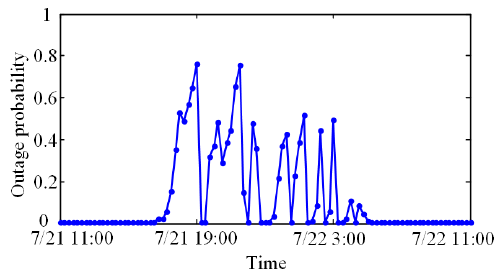
Figure 22. WT outage probabilities of Case 3.